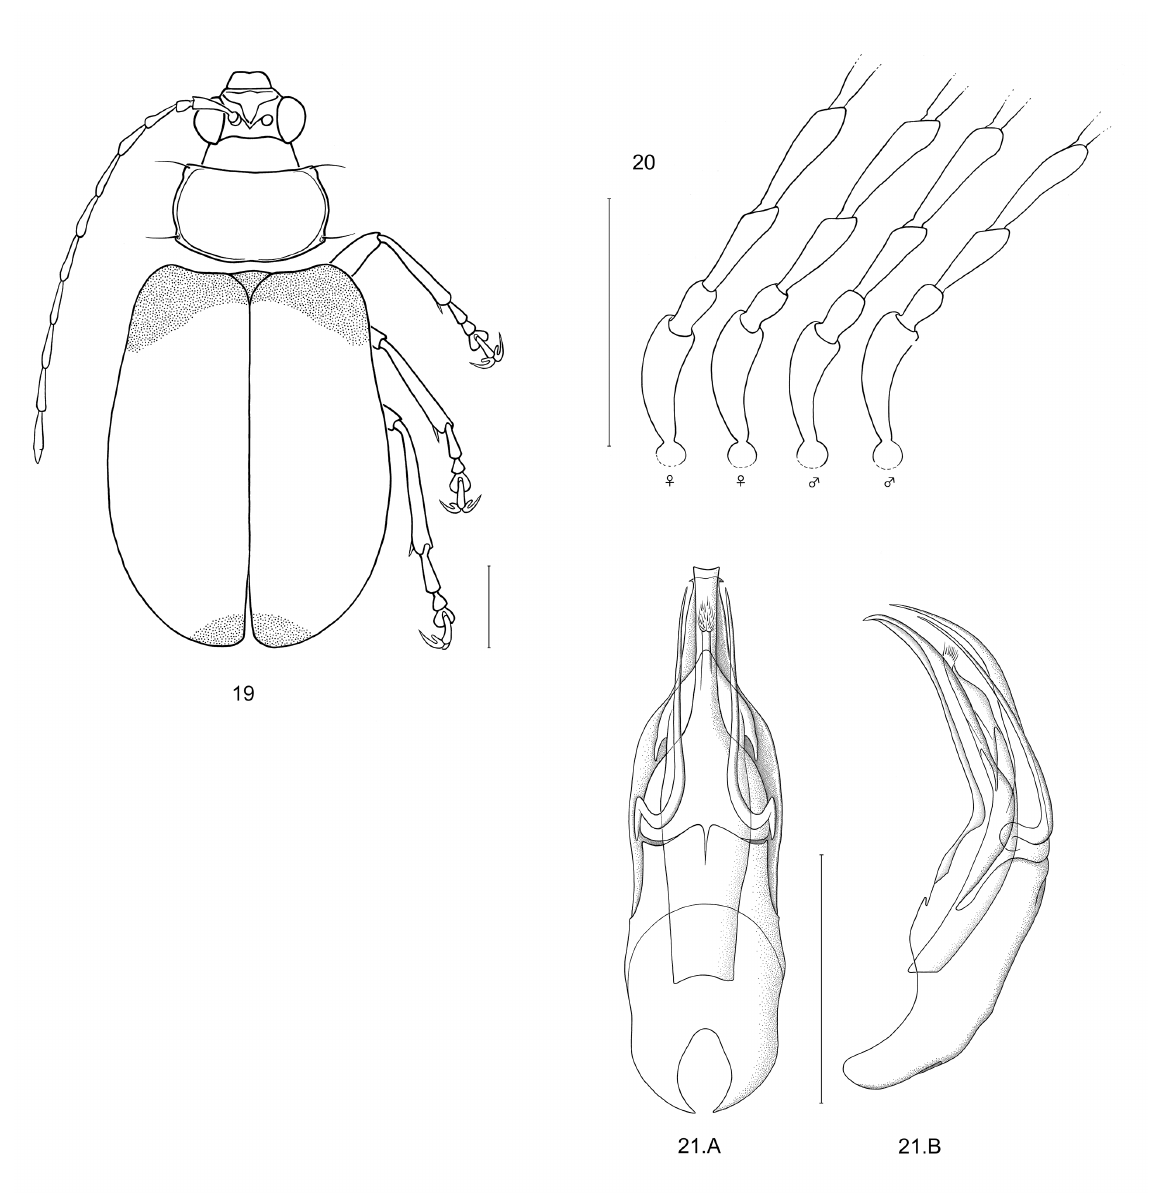
Figs 19-21. Oosagitta geescheae sp. nov. 19 . Habitus, semi-schematic dorsal view. 20 . Basal four antennomeres of 2 ♂♂ and 2 ♀♀. 21 . Median lobe. A . Dorsal. B . Lateral. Scale bars: 1